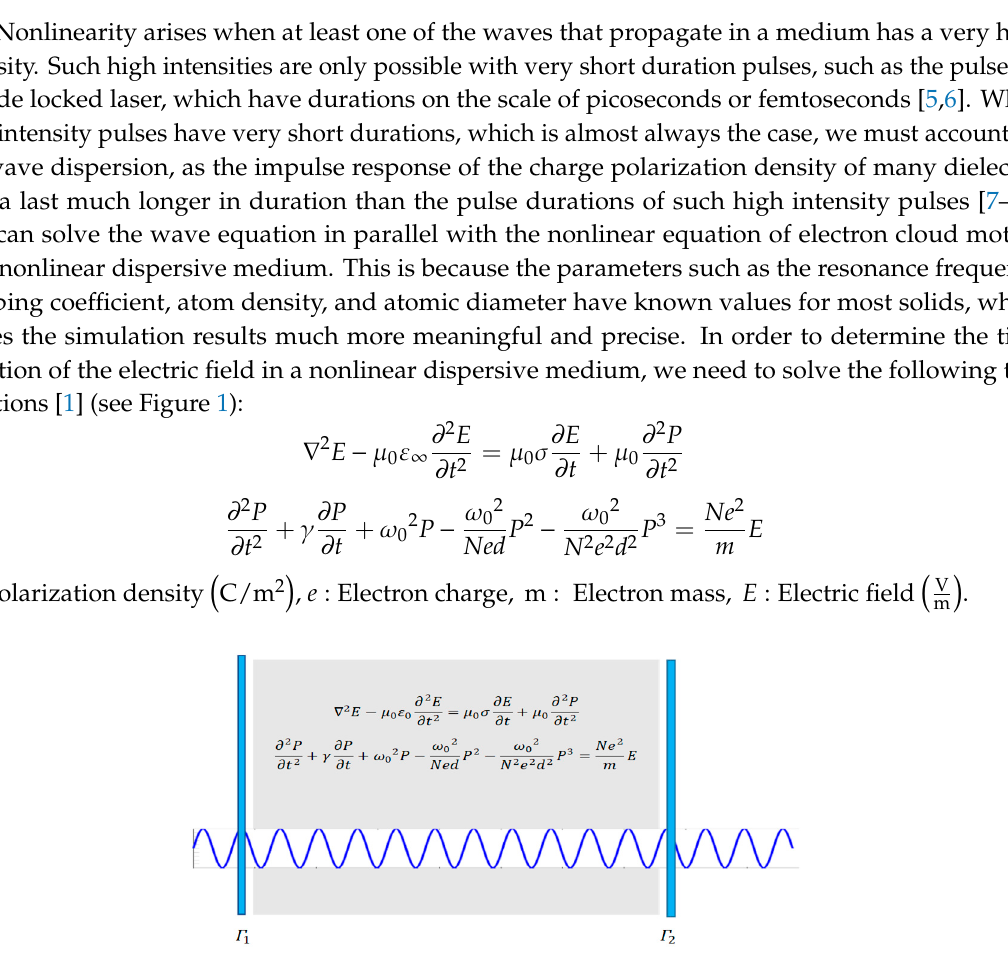
Figure 1. A nonlinear dispersive medium placed in a cavity.